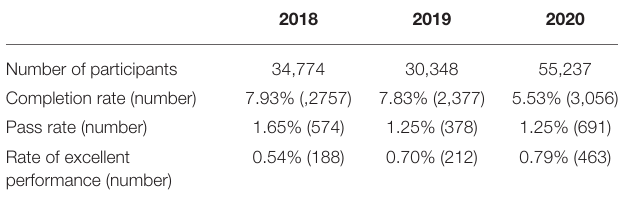
TABLE 1 | Performance of course participants in different years.